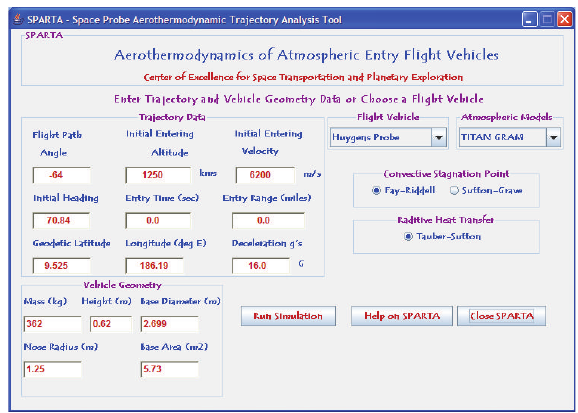
Figure 2: Sparta JAVA graphical user interface.